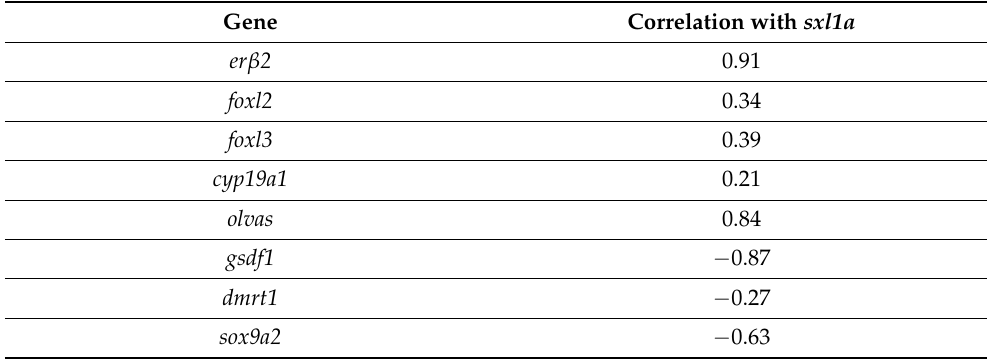
Figure 7. Evaluation of sxl1a and er β 2 interaction in XX female medaka. Transcriptional alterations of sxl1a ( A ) , er β 2 ( B ), gsdf1 ( C ), and tra2 ( D ) were measured using various embryonic stage samples of control-XX, sxl1 -KD, and er β 2 -KO medaka. Data are shown as the mean ± SEM and expressed as relative abundance, corrected for the average of ef1 α , β actin , and rps18 ; different letters denote significant differences at p < 0.05. Table 2. Analysis of correlation of sxl1a with candidate male and female-biased genes of medaka during embryonic development.